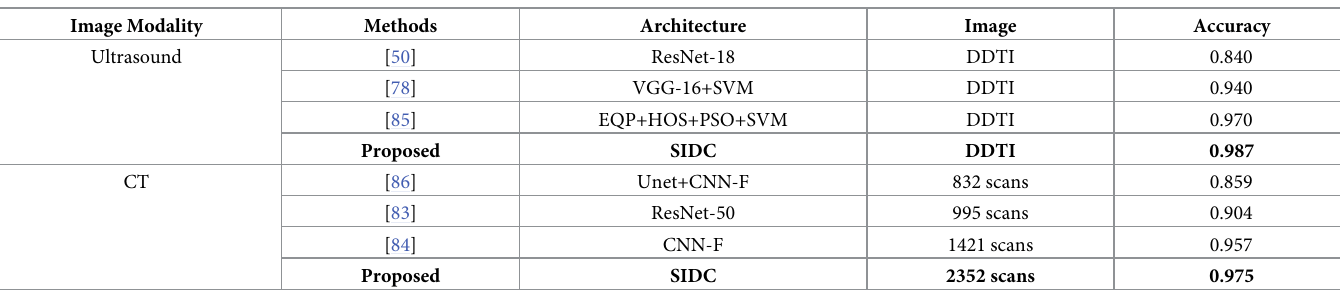
Table 6. Experiments comparison with existing